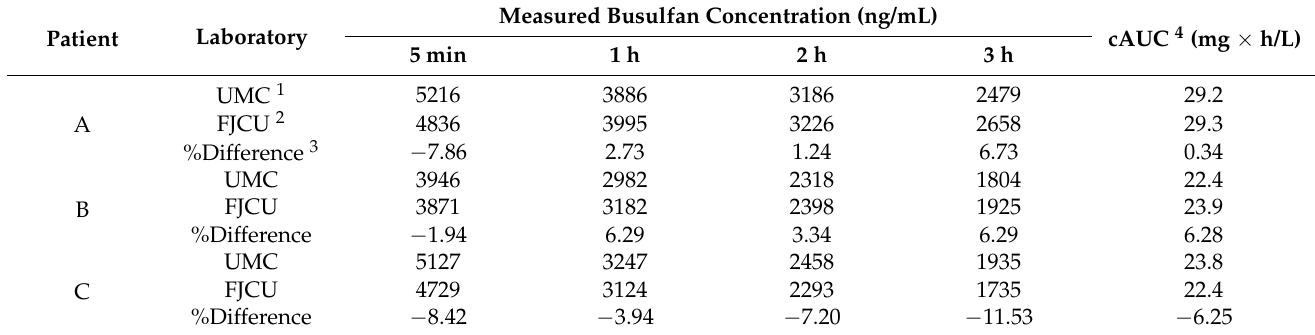
Table 3. Proficiency test between two laboratories.